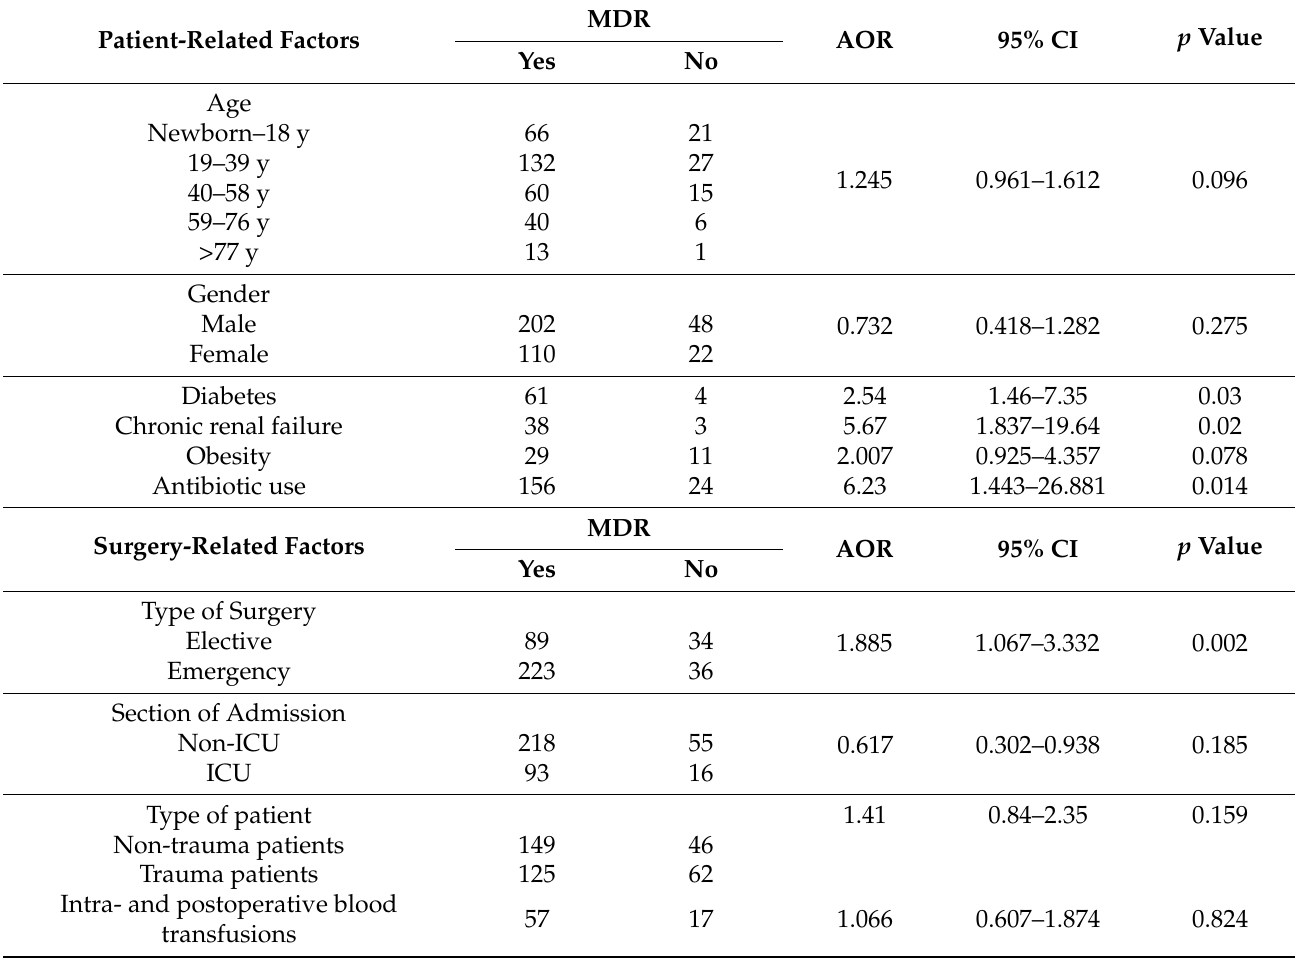
Table 1. Comprehensive analysis of risk factors predisposing to multidrug-resistant microorganisms causing surgical site